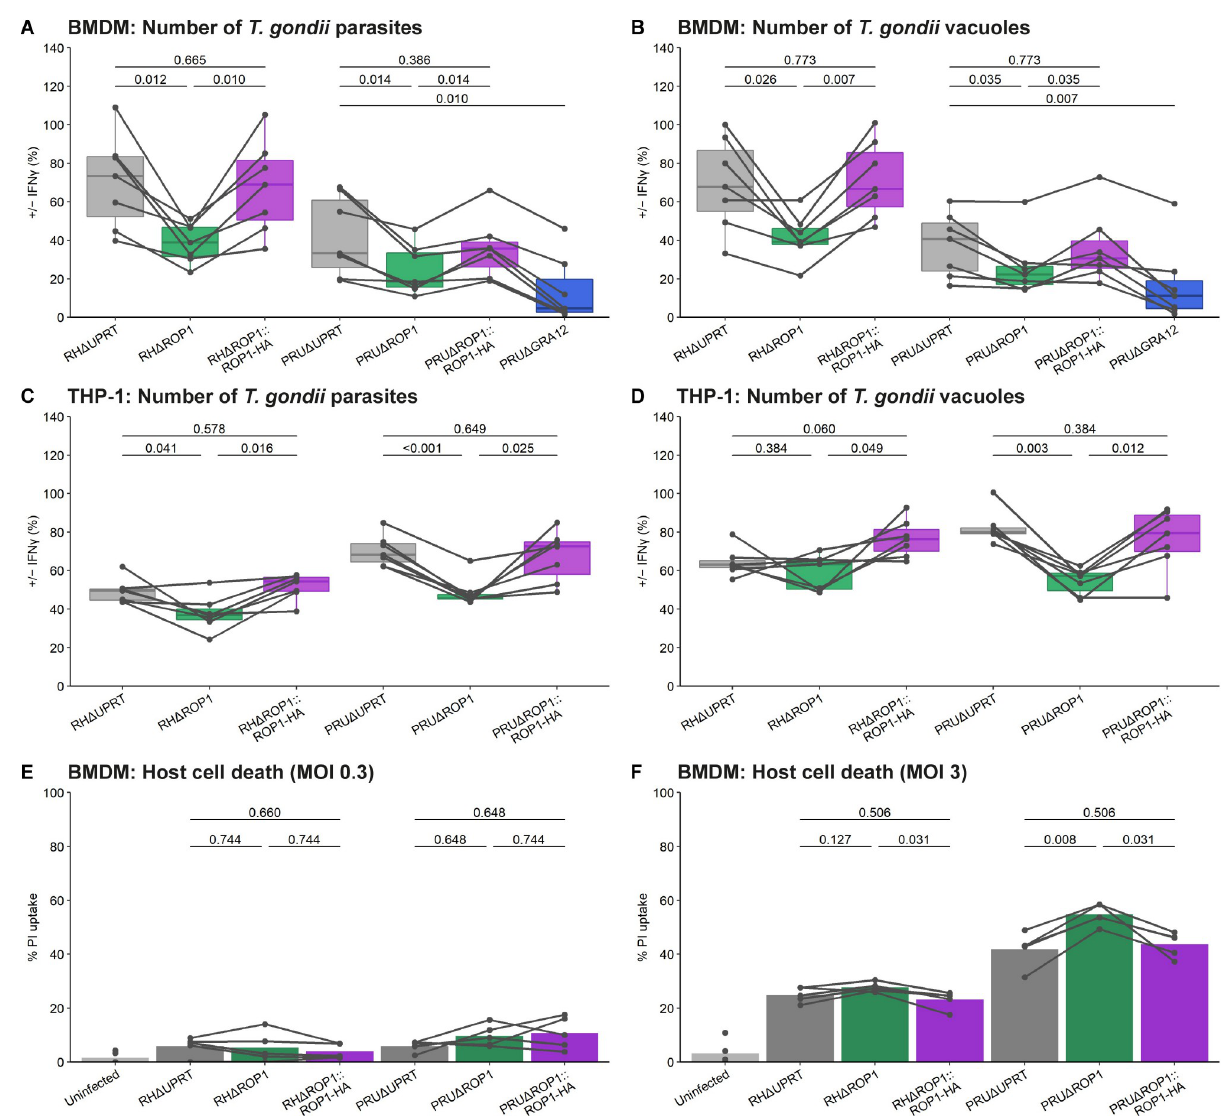
Fig 3. ROP1 contributes to T . gondii resistance to IFN γ in murine and human macrophages. A, B. T . gondii growth restriction in IFN γ -stimulated BMDMs infected at an MOI of 0.3 for 24 h, quantified by high-content imaging and automated analysis. Parasite growth in IFN γ -stimulated macrophages is shown as a percentage of that in unstimulated macrophages in terms of A total parasite number and B vacuole number. p-values were calculated by paired two-sided t- test with Benjamini-Hochberg adjustment. C, D. T . gondii growth restriction in IFN γ -stimulated THP-1-derived macrophages infected at an MOI of 0.3 for 24 h, quantified by high-content imaging and automated analysis. Parasite growth in IFN γ -stimulated macrophages is shown as a percentage of that in unstimulated macrophages in terms of A total parasite number and B vacuole number.p-values were calculated by paired two-sided t- test with Benjamini-Hochberg adjustment. E. F. Propidium iodide uptake of IFN γ -stimulated BMDMs infected at an MOI of E 0.3 or F 3 for 12 h. p-values were calculated by paired two-sided t- test with Benjamini-Hochberg adjustment.